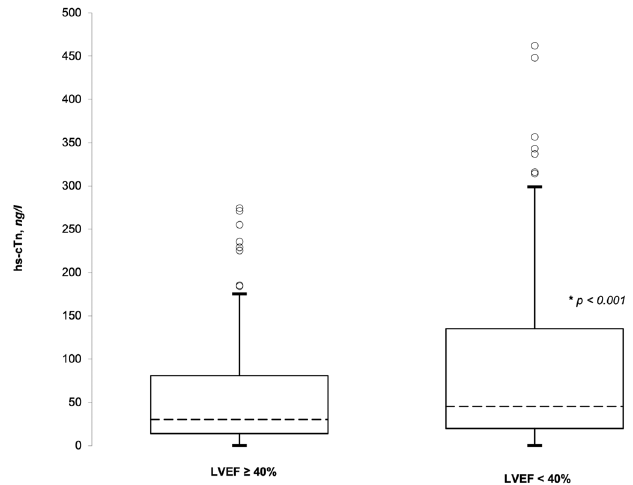
Figure 1. Absolute hs-cTnI values in patients with reduced and preserved ejection fraction. Median, IQR, 95% confidence range and extreme outlier data.